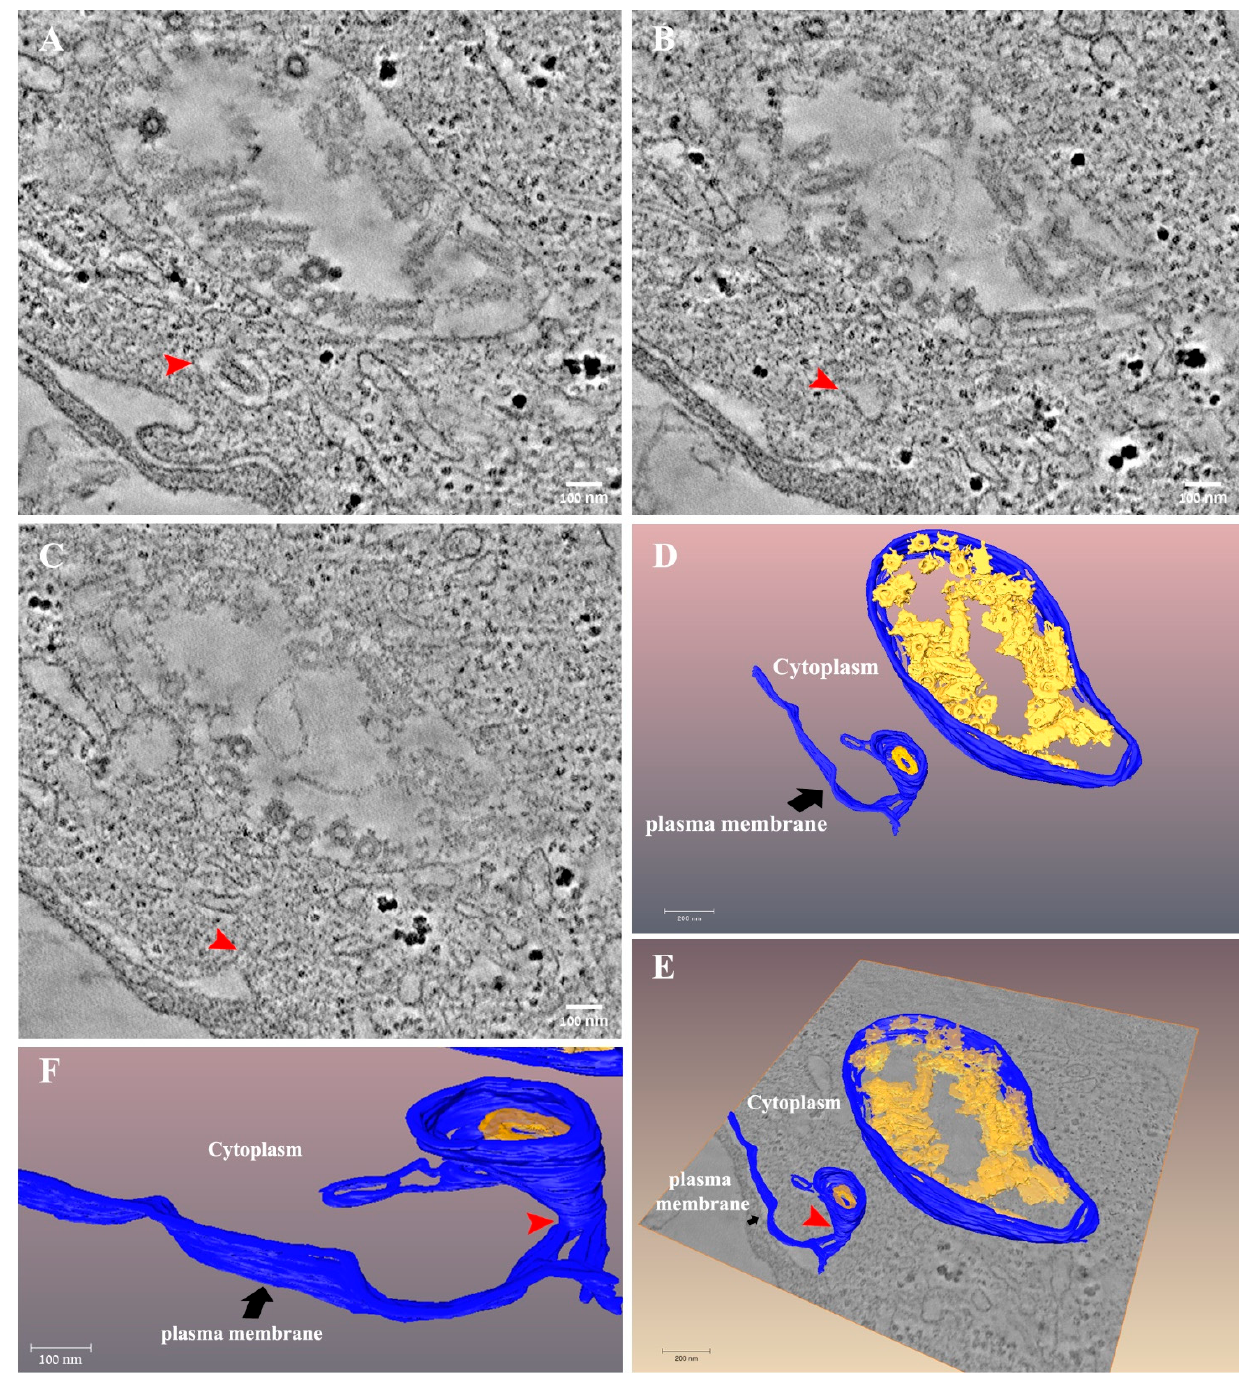
Figure 8. Release of VSV-S particles occurs after fusion of the vacuole membrane and the plasma membrane. ( A – C ) Sequential tomographic slices from a tomogram of 24 h post infection VSV-S infected cell. Red arrow points toward a VSV-S particle in a membrane vacuole ( A ). As the volume changes the vacuole becomes narrower (( B ), red arrow) and at a certain point in the volume, is connected to a protrusion in the plasma membrane (( C ), red arrow). ( D – F ) 3D surface rendering of the tomogram in panel ( A ). A large vacuole is depicted (blue color) with numerous virus particles decorated with probable spike proteins (yellow). A vacuole containing an individual virus particle is located nearby and is connected to the plasma membrane (blue) through a narrow membrane neck (red arrow). Tomographic slice thicknesses are 7 nm. Scale bars in panels ( A – C ) are 100 nm.